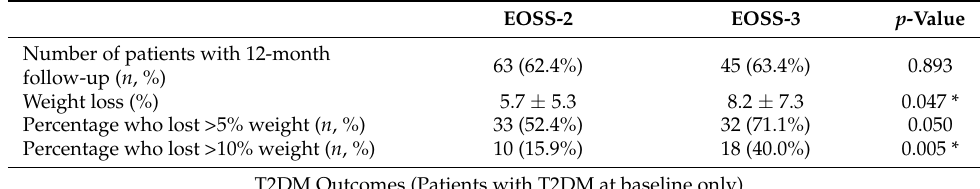
Table 4. Comparison at 12 months by initial